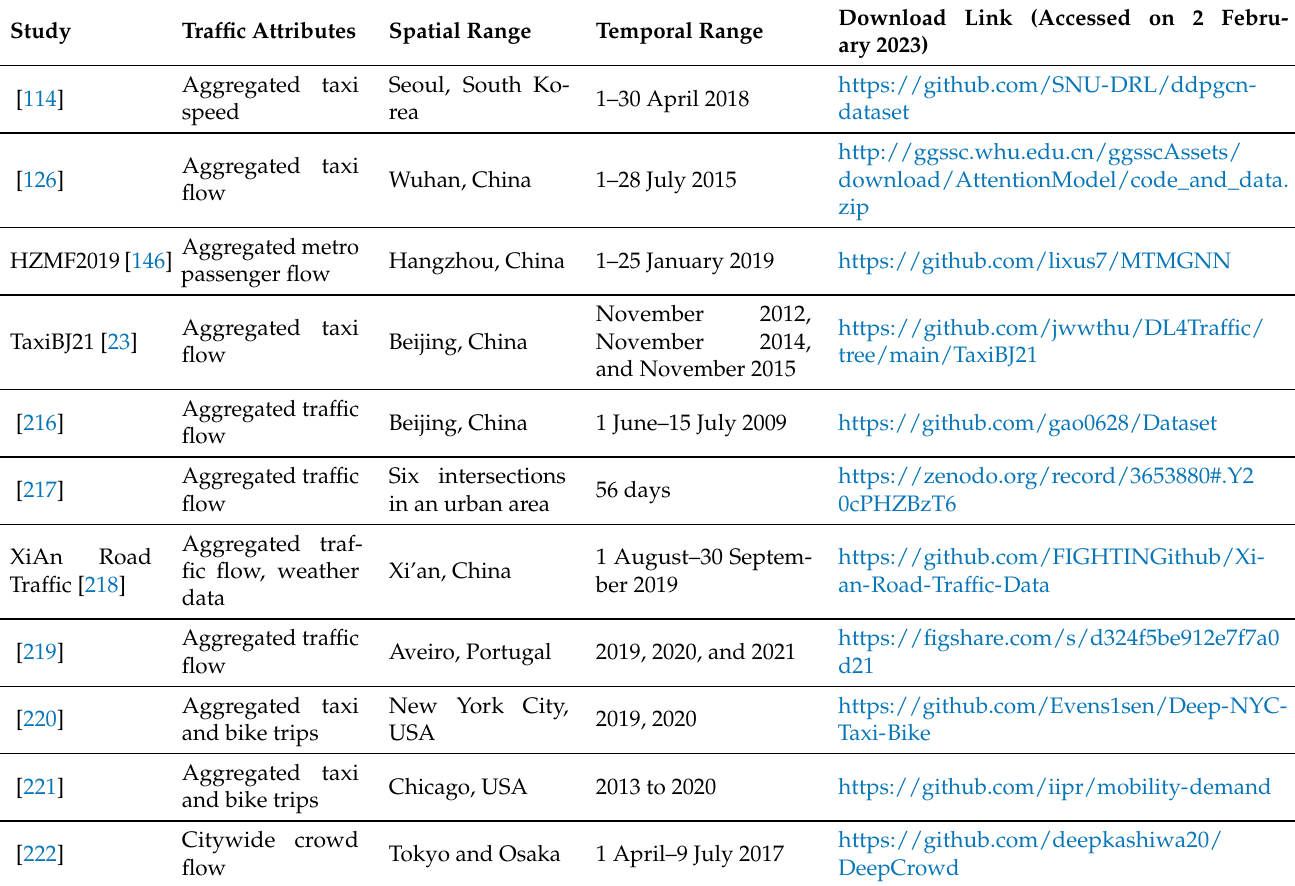
Table 2. The list of new open traffic